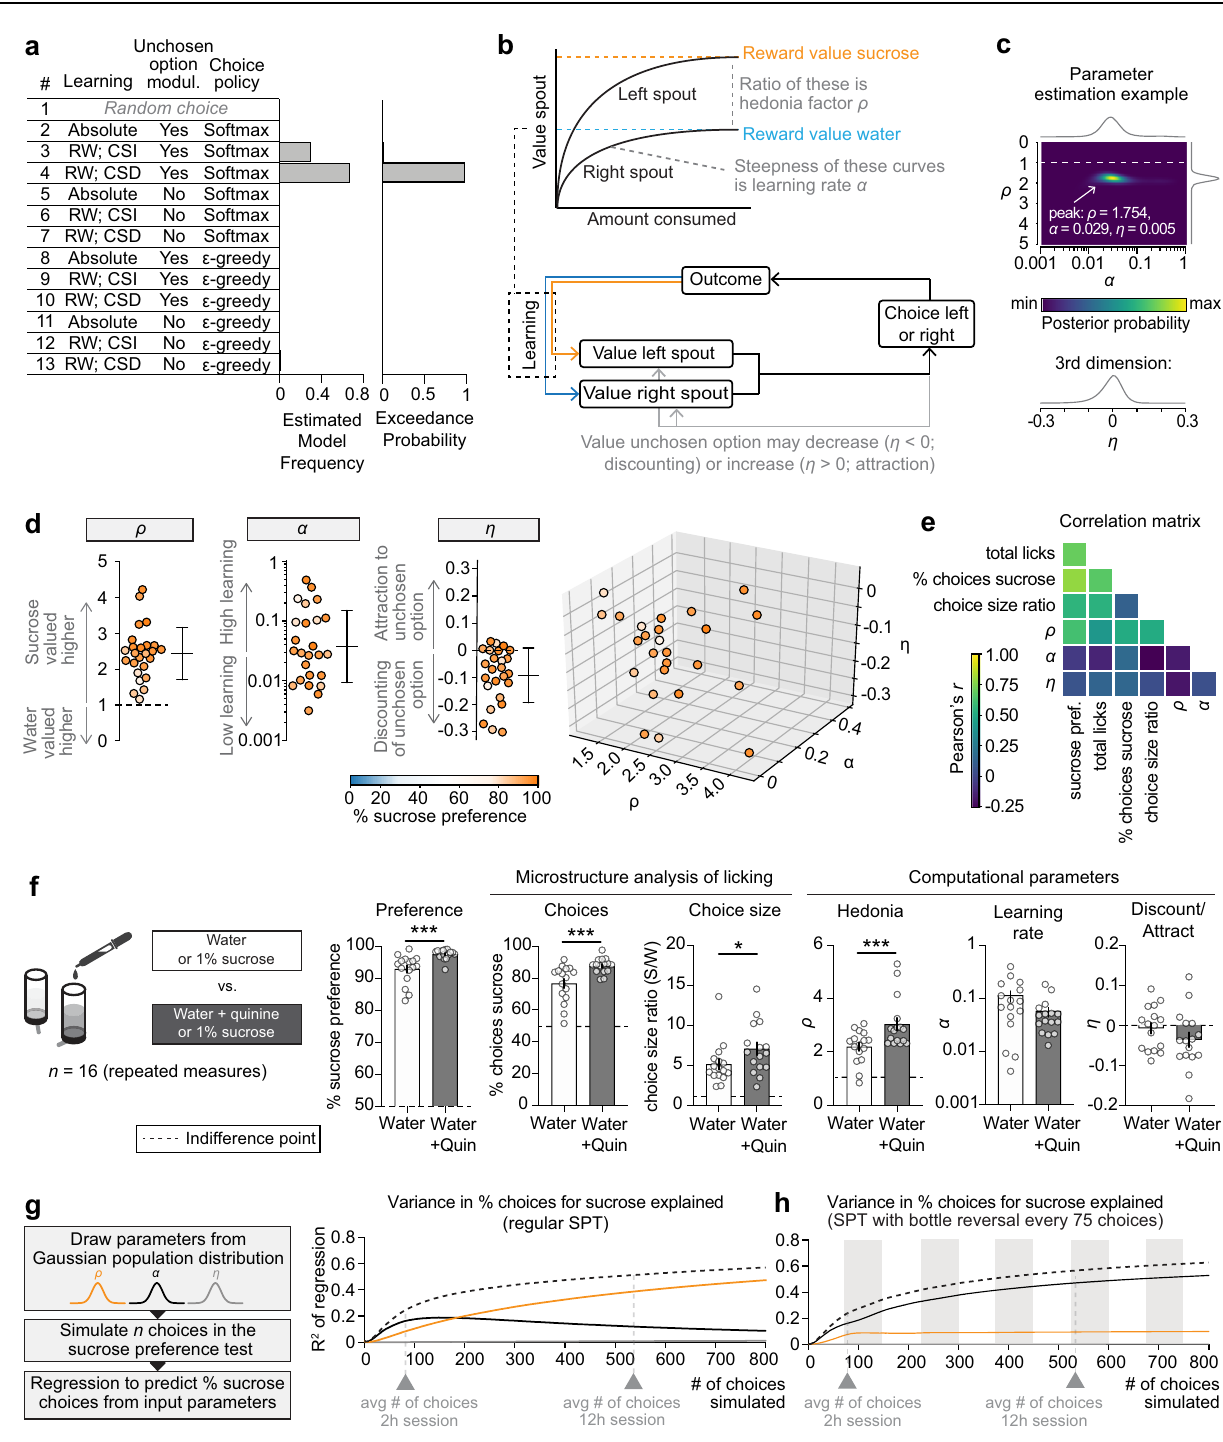
Variance in % sucrose choices explained by each